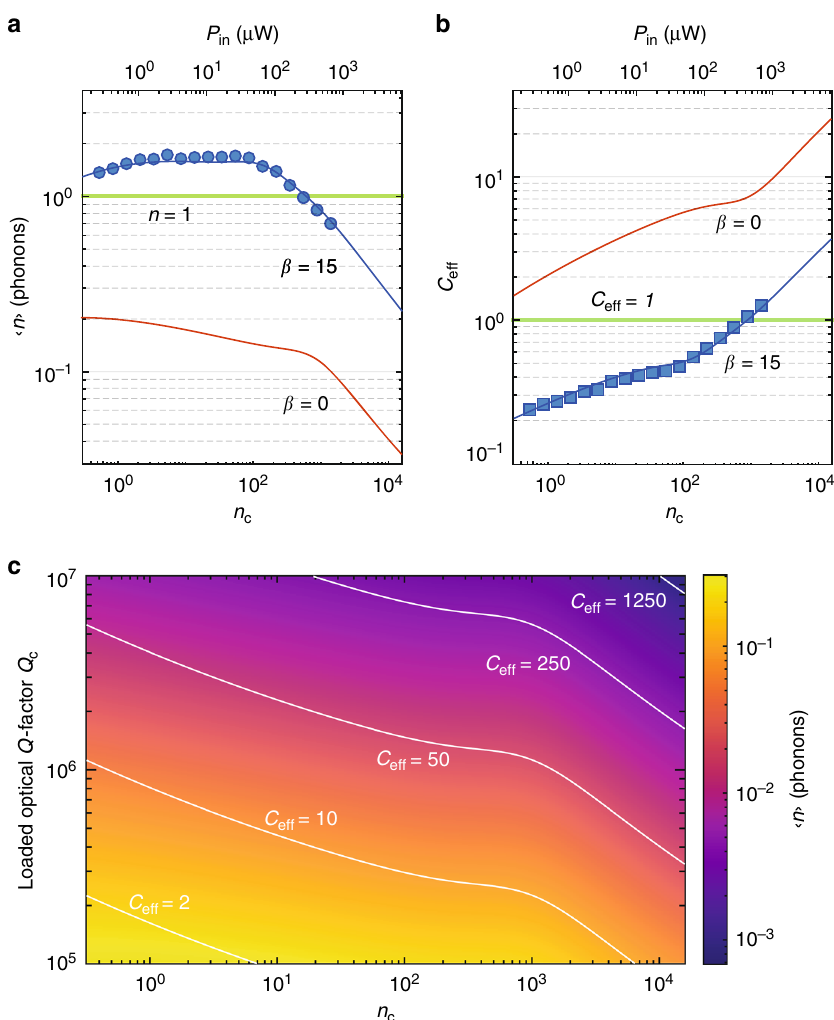
Fig. 5 Phonon occupancy and effective quantum cooperativity. a Plot of the measured occupancy 〈 n 〉 in the acoustic mode at ω m /2 π = 10.02 GHz versus laser pump power in units of intra-cavity photons, n c , and optical power coupled into coupling waveguide, P in . Filled blue circles are measured data. b Plot of quantum cooperativity C eff versus n c and P in . The C eff data points ( fi lled blue squares) are inferred using Eq. (1) from the measured 〈 n 〉 in a along with the fi t to the measured n p and γ p from Fig. 4. In both a and b , the solid curves are theoretical plots calculated using the power-law fi ts of γ p and n p considering optical heating from n c alone ( β = 0, red solid line curve) and including direct heating from P in with β = 15 μ W − 1 (blue solid curve). c Estimated back-action cooled phonon occupancy 〈 n 〉 for a quasi-2D OMC device with the same properties as measured in a save for a modi fi ed Q -factor and no waveguide heating ( β = 0). White solid curves delineate contours of constant quantum cooperativity C eff . In a , b , quasi-2D OMC cavity measurements are for the same device as in Figs. 3c and Agiltron switches with the time-correlated single-photon-counting module, which path can be switched by 2 ×2 optical switches between two paths: (i) a “ balanced is connected to a single-photon detector (SPD). The SPDs used in this work are heterodyne spectroscopy ” path with a high-speed photodetector for performing balanced heterodyne detection of the acoustic mode, and (ii) a “ photon counting path ” with a single photon detector for performing either pulsed or continuous- wave phonon counting of the acoustic mode. For the balanced heterodyne spectroscopy path, a 90:10 beam splitter divides the laser source into local oscillator (LO; 90%) and signal (10%) beams. The LO is modulated by an electro-optic modulator (EOM) to generate a sideband at δ /2 π = 50MHz from the mechanical frequency. One of the modulated sidebands of LO is selected using a high- fi nesse tunable Fabry – Perot fi lter before recombining it with the signal for detection. The signal path is sent through a variable optical attenuator and then to an optical circulator, which directs the signal to the device under test in the DR. A lensed optical fi ber in the DR is used to couple light into and out of the devices. The re fl ected signal beam is recombined with the LO using a variable optical coupler, the outputs of which are sent to a balanced photodetector. For the photon counting path, the laser is directed via 2× 2 mechanical optical switches into a “ high-extinction ” branch consisting of an acousto-optic modulator (AOM; 20ns rise and fall time, 50 dB on – off ratio) and two Agiltron NS switches (Ag.; 100 ns rise time, 30 μ s fall time, total of 36dB on – off ratio), which are driven by a digital delay generator to generate high-extinction-ratio optical pulses. The fi t to determine η κ and κ . With these two parameters, we determine n digital delay generator is used to synchronize the switching of the AOM and c for a given